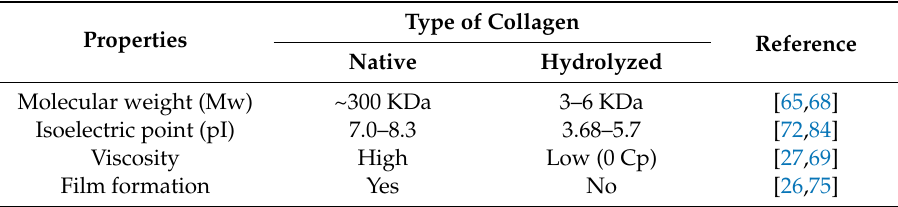
Table 1. Properties of native and hydrolyzed